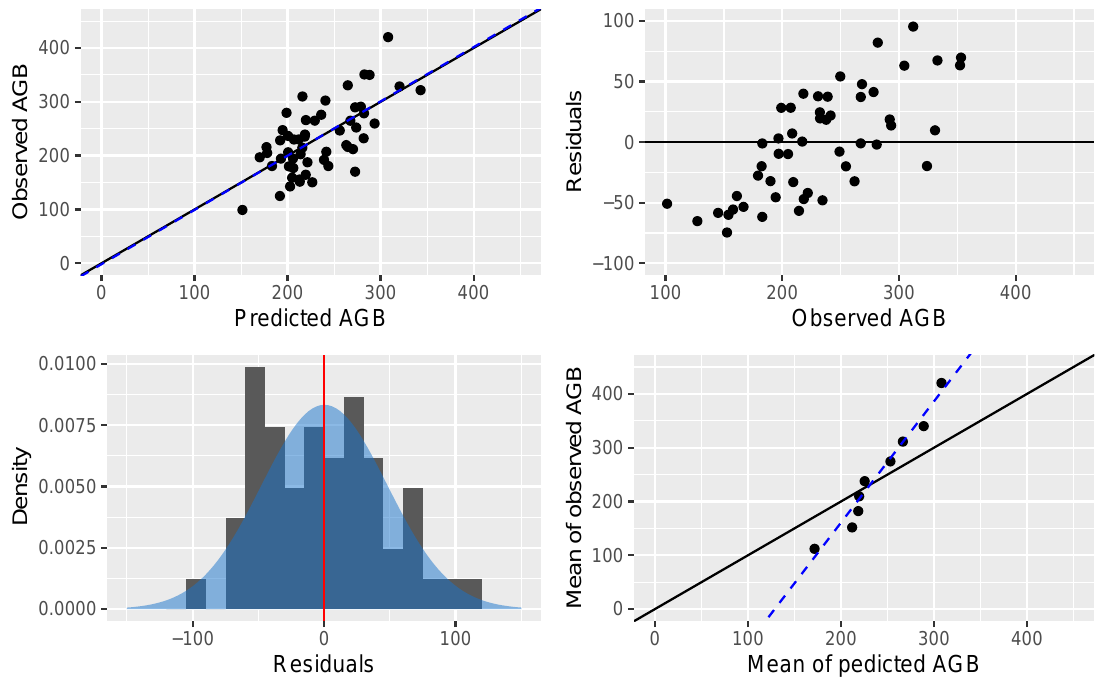
Figure 5. Plots for analyzing the biomass-link model with the AGB observations versus nonlinear logistic model predictions (top left), model residuals versus observed AGB values (top right), histogram of the residuals including a normal distribution curve (blue) with the same mean and standard deviation (lower left), and mean value of predicted AGB versus mean value of observed AGB values. All AGB values are in